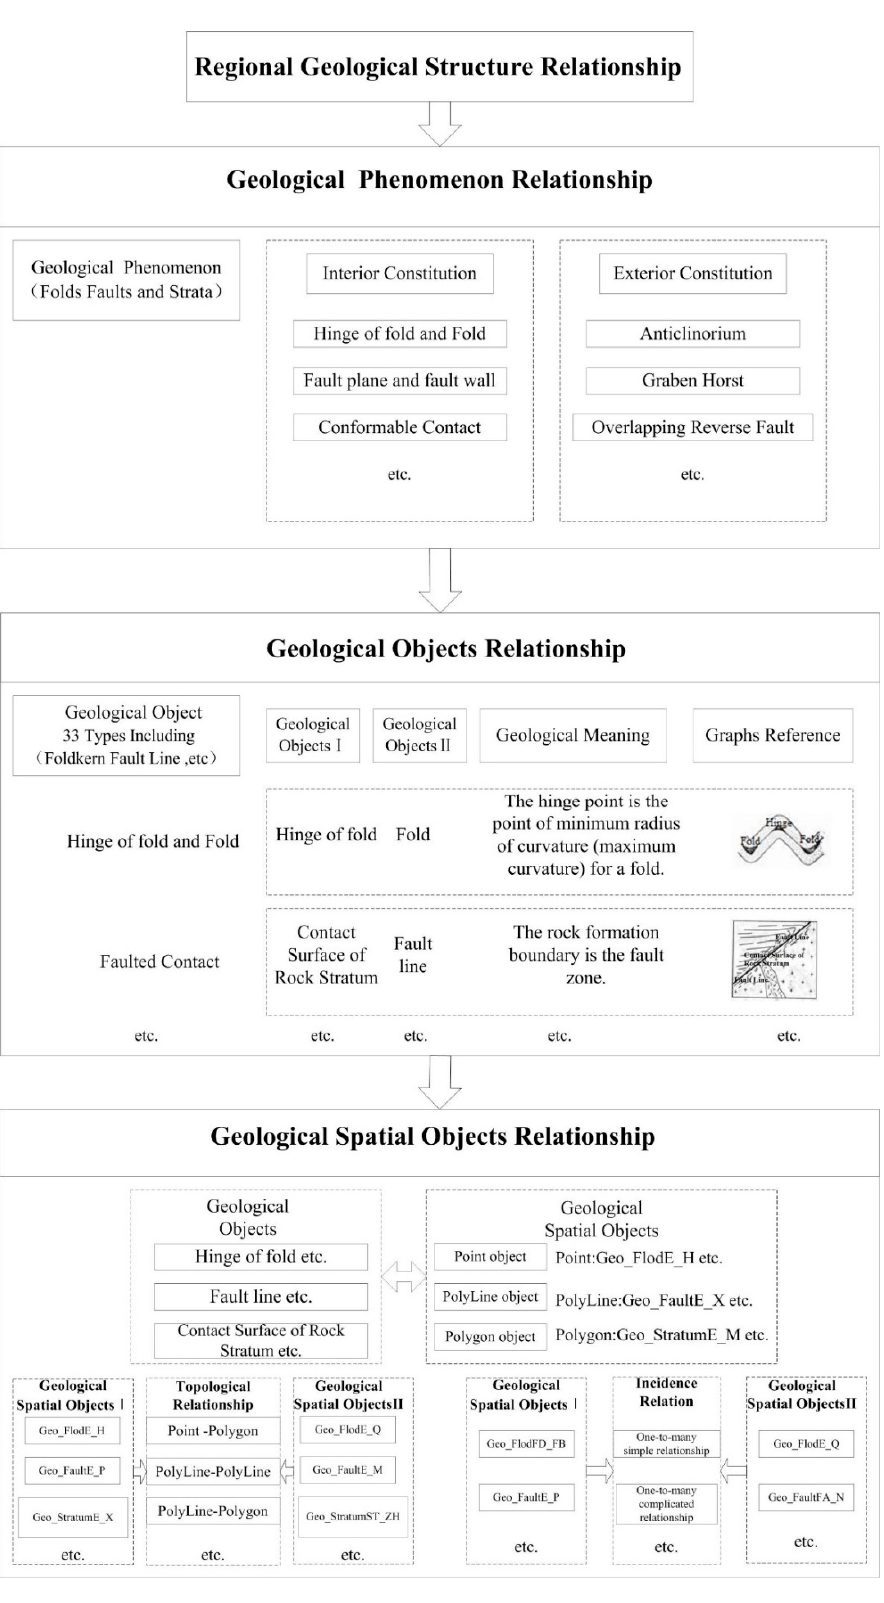
Figure 1. Modelling solutions of geological relationships at three levels.